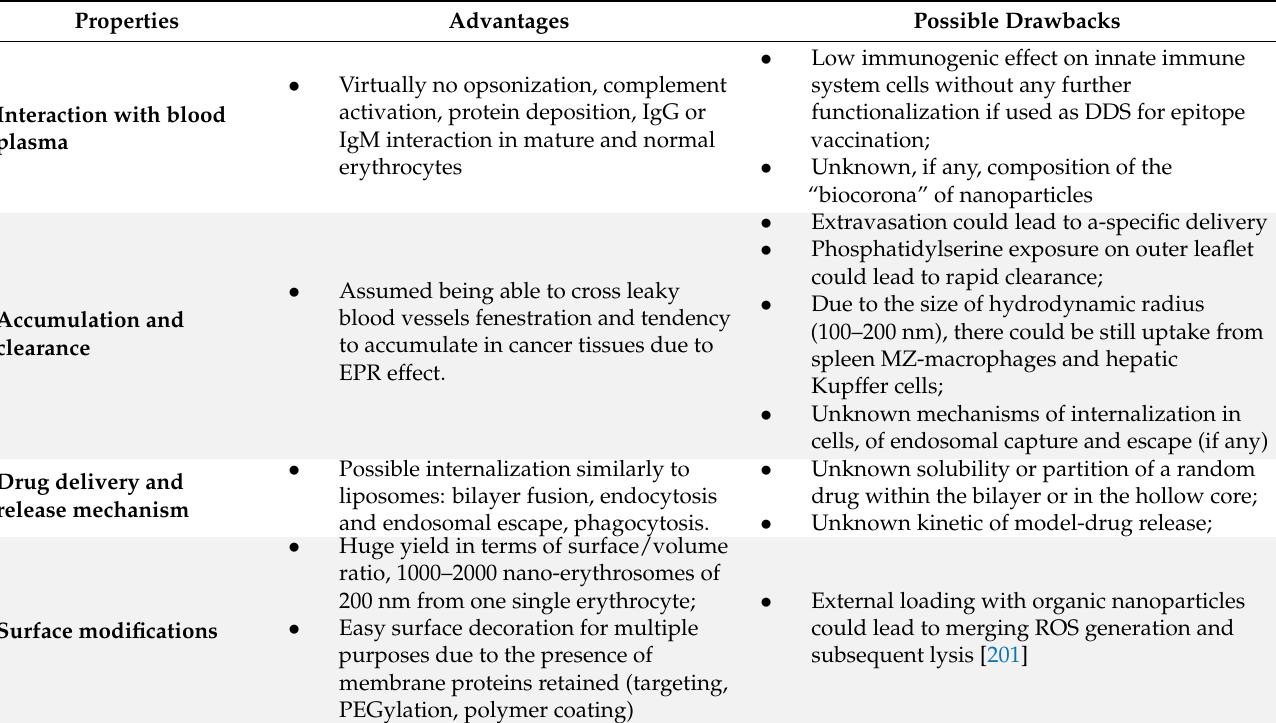
Table 3. Summary of established advantages and possible drawbacks of nano-erythrosomes use as drug carrier.